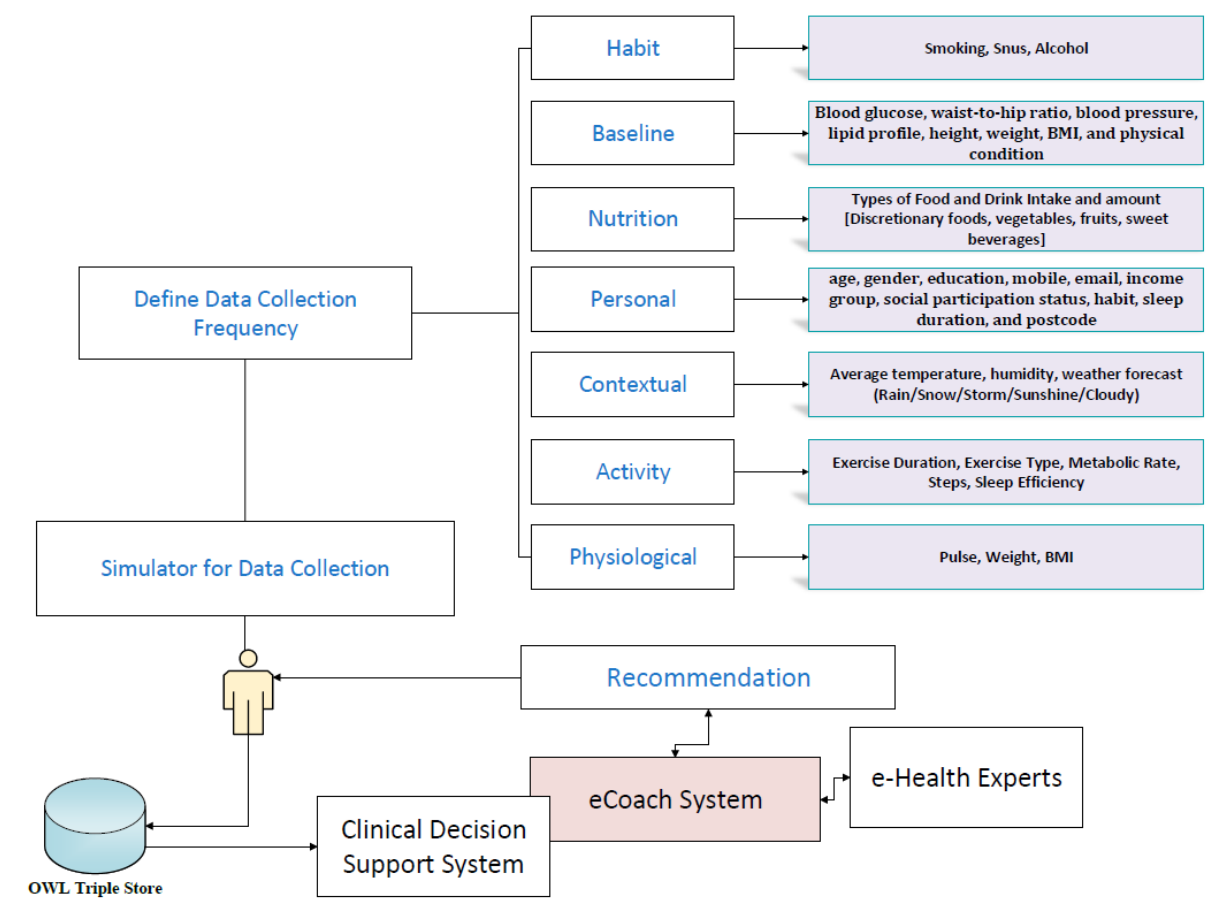
Figure 3. Types of data to be collected from